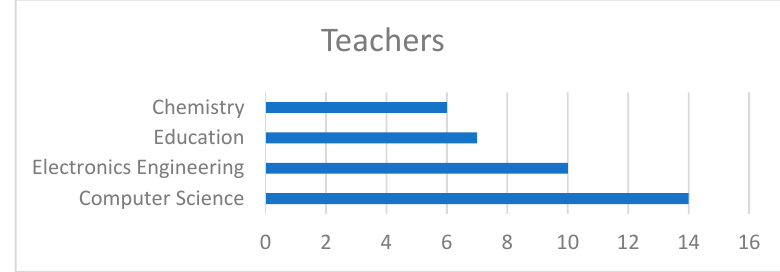
Figure 1. Teacher programs.